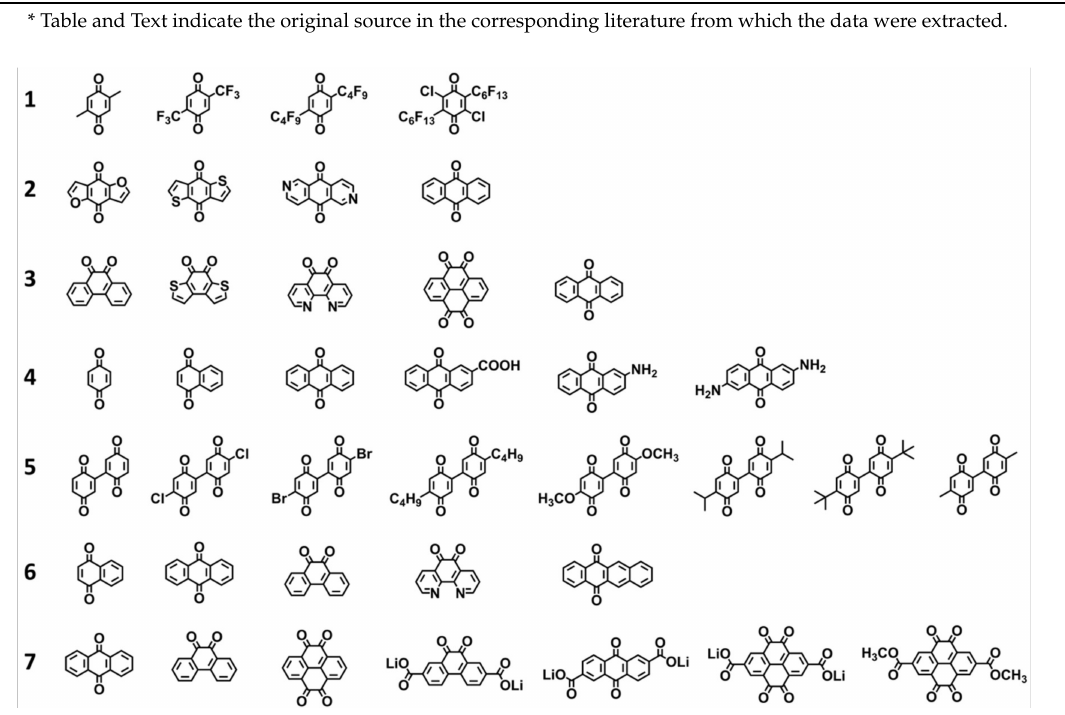
Figure 1. 2D structures of the molecules that were used for the calibration of computational methods. A total of seven different experimental datasets were considered in the current